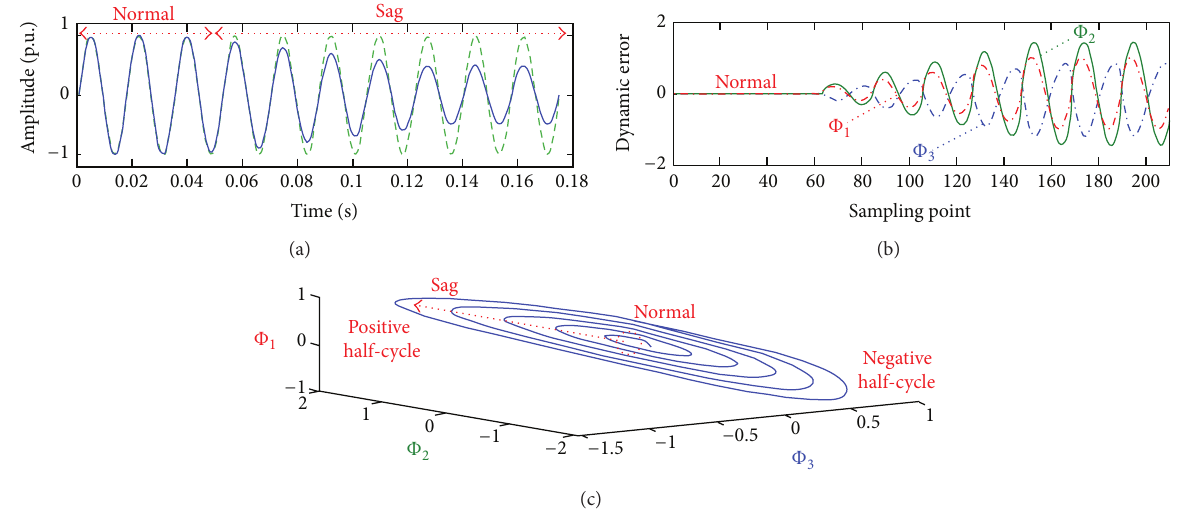
Figure 3: Experimental simulation results. (a) Coupling signal: ideal periodic voltage signal and voltage sag signal, (b) dynamic errors Φ 1 , Φ Φ 2 , and 3 , and (c) phase diagram of CS